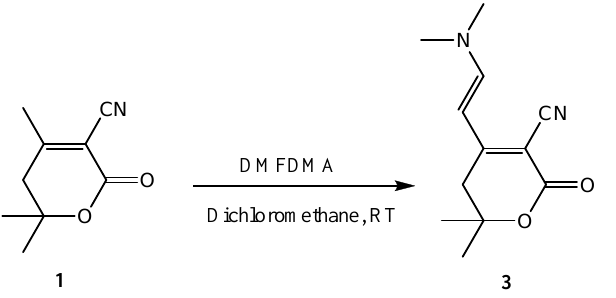
Figure 2. Synthesis of enaminolactone nitrile 3 .